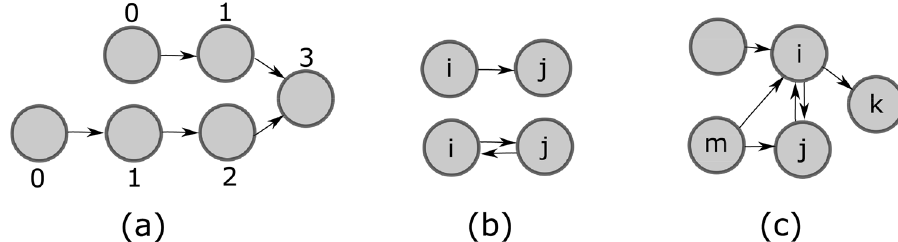
Fig 1. Graphs and notation. In (a), we number the levels of all nodes in a directed acyclic graph. In (b), given two agents i and j , we represent relationships of subordination in the upper figure (here, i is j ’s subordinate), and ð i ; G Þ ¼ f j ; m g , N ð j ; G Þ ¼ f i ; m g , N s collaboration in the lower figure. In (c), N in in ð k ; G Þ ¼ N s ð k ; G Þ ¼ f i g , P ( G , m ) = P ( G , m ) = P ( G ) = P ( G ) = { i , j }. N i j i j in in